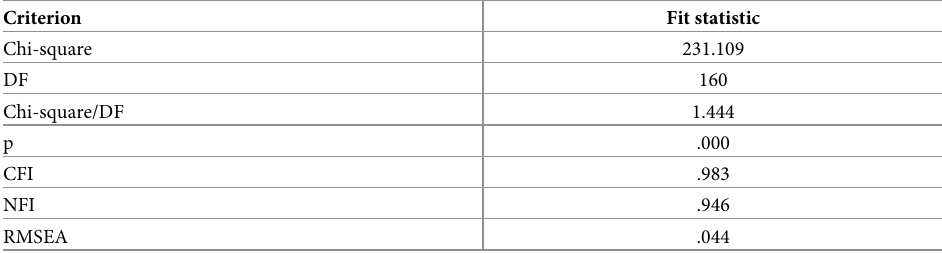
Table 3. Measurement model fit statistics.